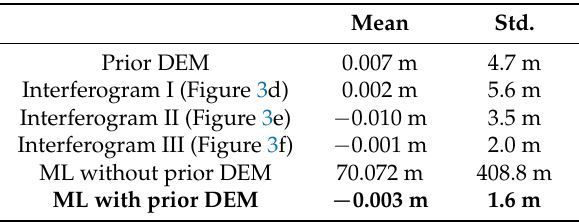
Table 3. Statistical values of height errors without atmospheric